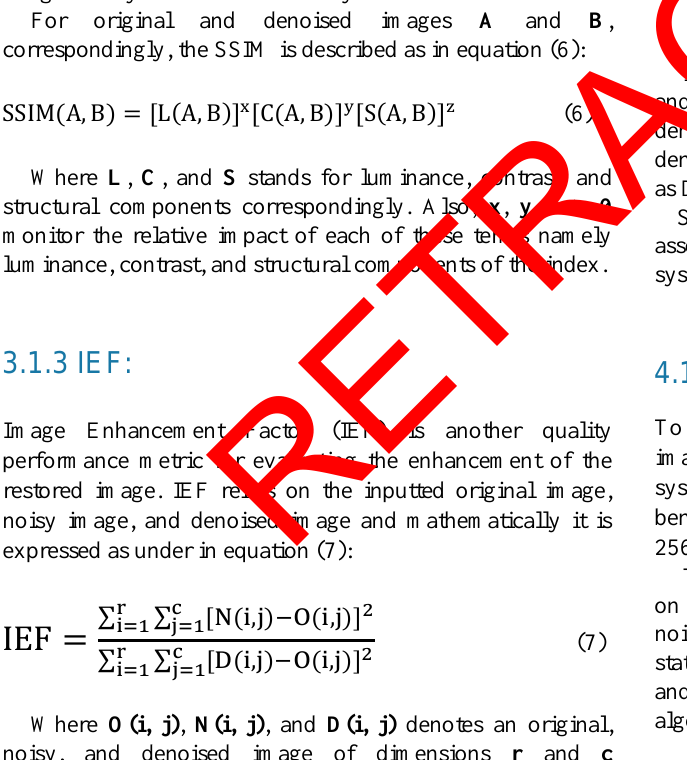
Figure 4. Benchmark images used in the proposed